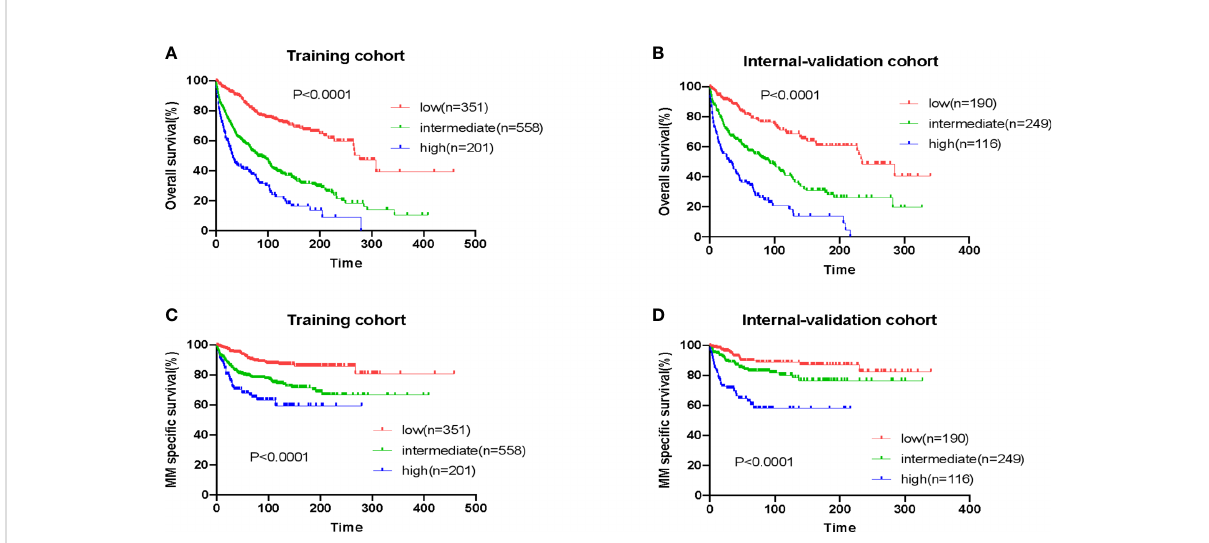
FIGURE 4 Overall survival and myeloma-speci fi c survival according to EMP-PI: overall survival of patients with extramedullary plasmacytoma (EMP) from three risk groups in the training cohort (A) and the validation cohort (B) ; myeloma-speci fi c survival of patients with EMP from three risk groups in the training cohort (C) and the validation cohort (D) .